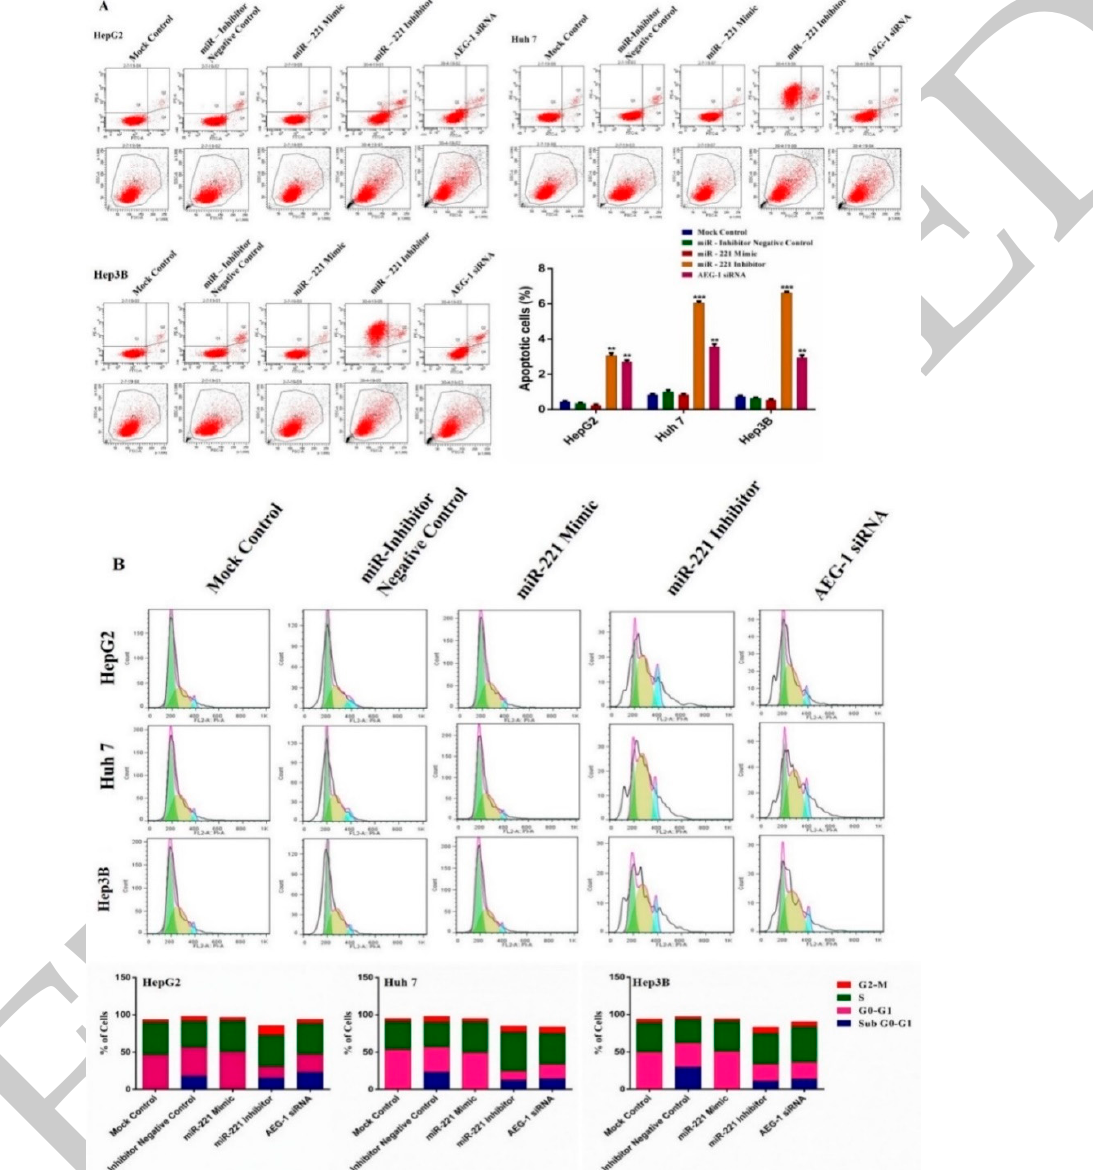
Figure 6. Inhibition of miR-221 and AEG-1 induces apoptosis and cell cycle arrest in HCC cells. Effect of miR-221 and AEG-1 on apoptosis ( A ) and cell cycle ( B ) was analyzed in mock control, inhibitor negative control, miR-221 mimic, and miR-221 inhibitor, and AEG-1 siRNA transfected HCC cells by flow cytometry. Blue color denotes G2-M phase peak, yellow color denotes S phase peak and green color denotes G0-G1 phase peak; block and red color line denotes sub G0-G1 phase peak. Transfection of miR-221 Inhibitor and AEG-1 siRNA induces apoptosis and cell cycle arrest compared with their negative controls transfected HepG2, Huh7, and Hep3B cells in vitro. Error bars are presented as the mean ± s.d.** p < 0.01, *** p < 0.001 compared to the control group.